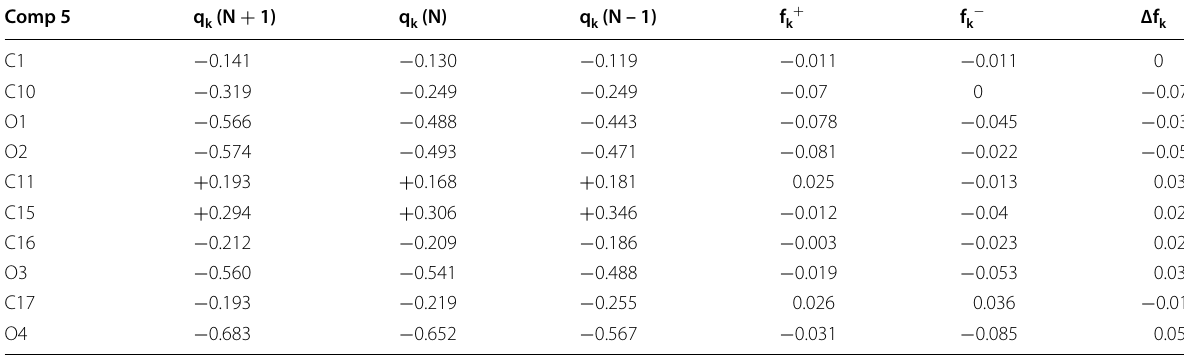
Table 6 Selected Mulliken atomic charges and Fukui functions for Compound 5 Comp